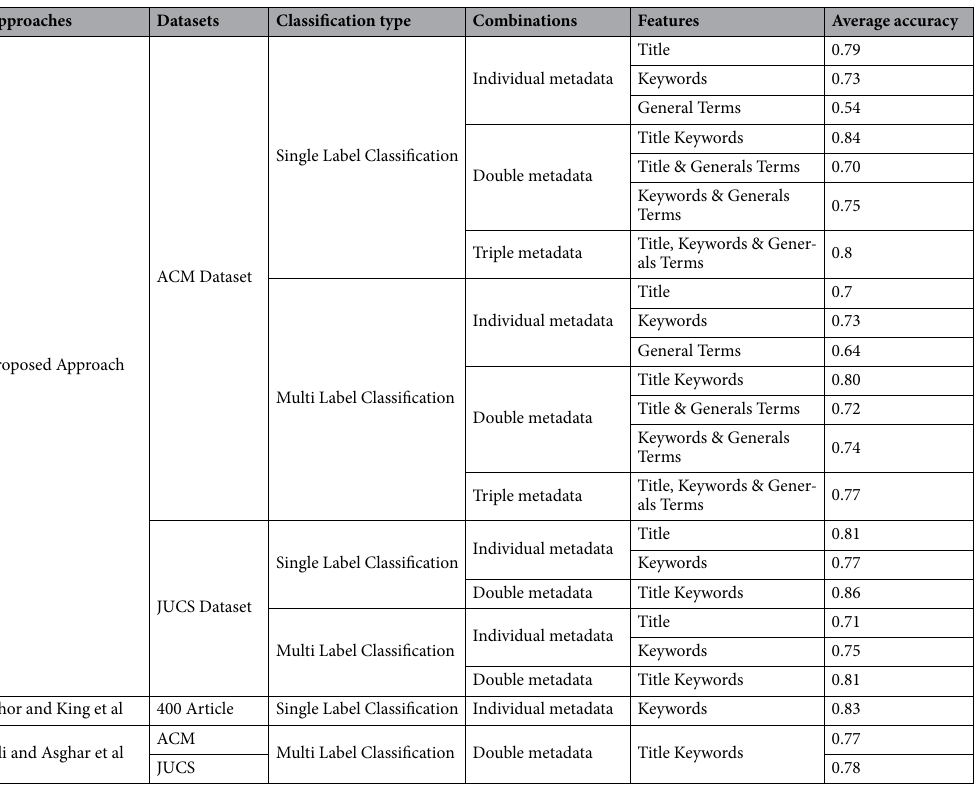
Table 5. Overall